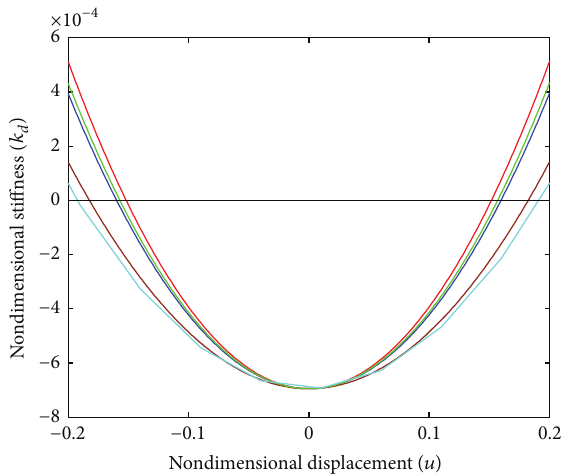
Figure 5: Nondimensional stiffness characteristics of the disk springs for different |𝜅| . “Red line” 𝜅 = 0 (constant thickness); “blue line” 𝜅 = 0.5 ; “brown line” 𝜅 = 1 ; “green line” 𝜅 = −0.5 ; “cyan line” 𝜅 = −1